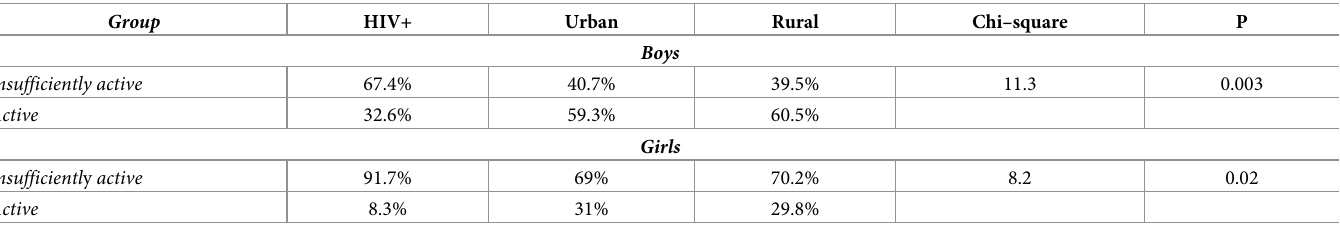
Table 7. Comparison of subjects according to activity categories classified by the average amount of time spent in MVPA; p values resulted from the Chi-square test.